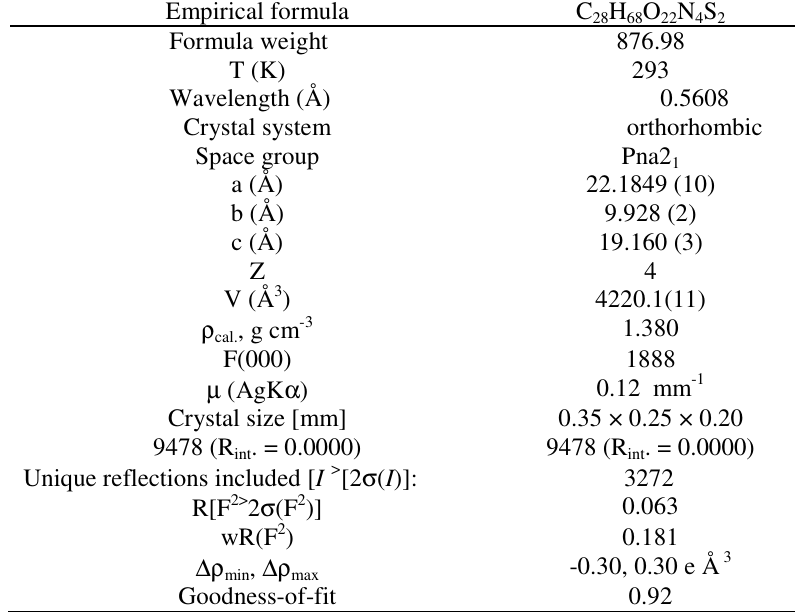
Table 1. Crystal data and experimental parameters used for the intensity